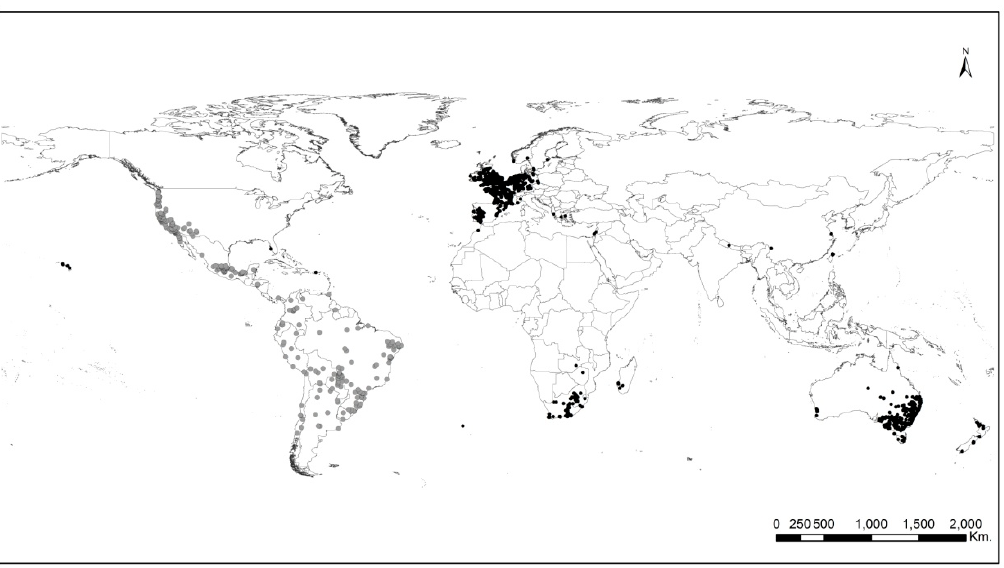
Figure 1. Global geographic distribution of Azolla filiculoides . Grey dots represent native occurrence localities and black dots represent invaded occurrence localities.